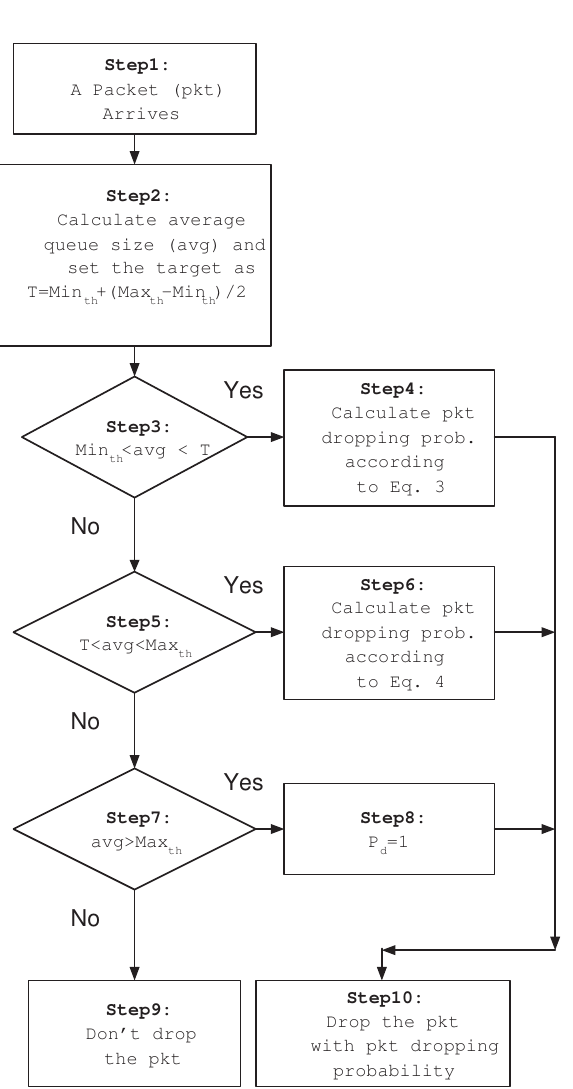
Figure 5. The detailed proposed packet discard